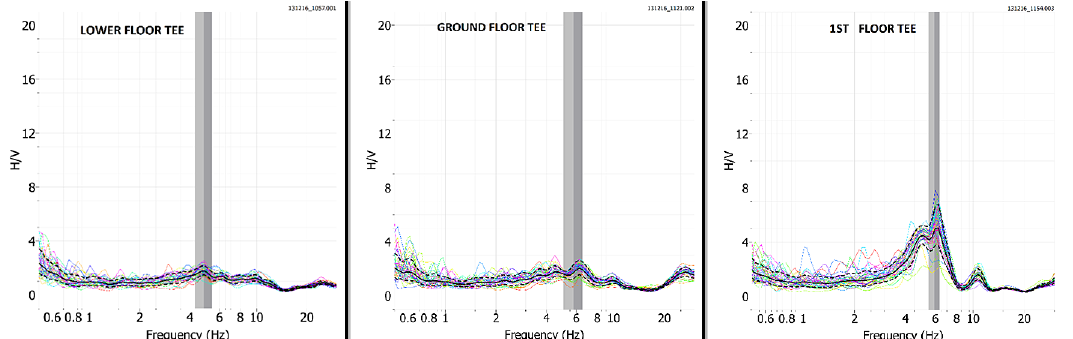
Figure 22. HVSR plots of acceleration recordings for lower floor of TEE building (left figure), ground floor of TEE building (middle figure) and first of TEE building (right